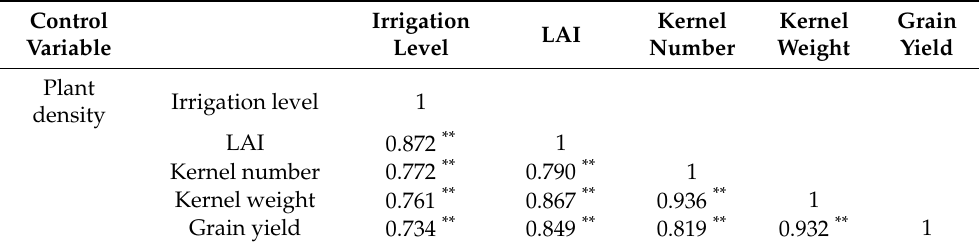
Table 5. Correlation among irrigation level, LAI, kernel number, kernel weight, and grain yield of maize under plant density in 2016 and 2017.